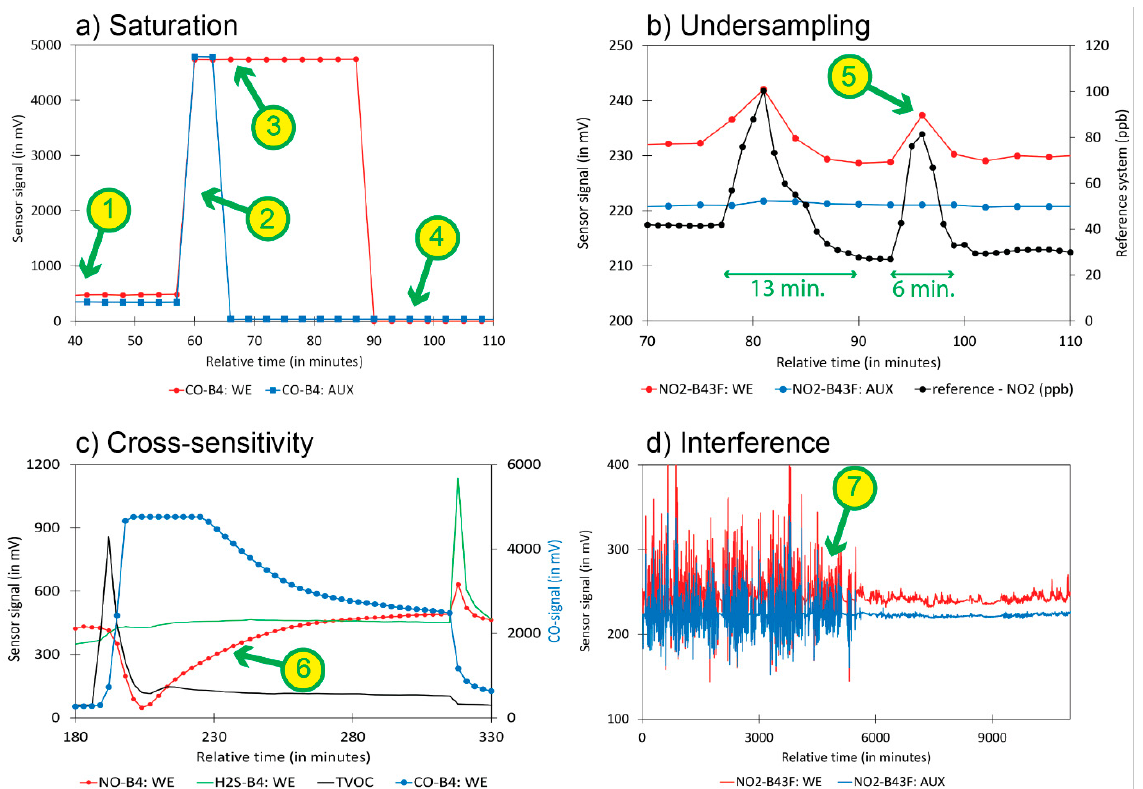
Figure 7. Raw sensor readings over time for the CO-B4 and NO2-B43F sensors and some sensor errors identified during a variety of monitoring campaigns. The signal of the working electrode is abbreviated as WE and of the auxiliary electrode as AUX; ( a ) A situation where the working electrode of the CO-sensor is saturated; ( b ) A situation where a peak consists of only one data point; ( c ) Situation of cross-sensitivity where NO shows a negative peak; ( d ) Situation where the environment creates noise in the WE and AUX signals and where this interference stops at some